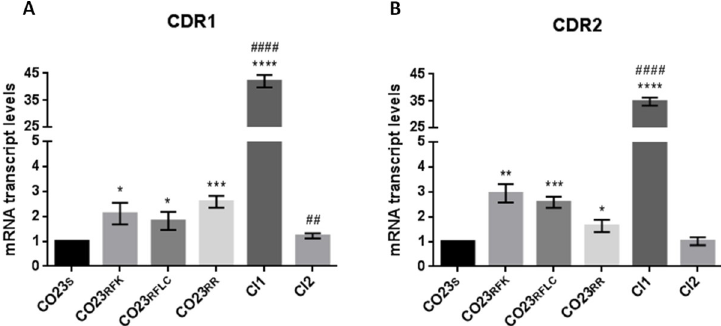
Fig 2. Expression levels of C . albicans CDR1 and CDR2 genes determined by quantitative Real-Time PCR. The expression level of the CDR1 (A) and CDR2 (B) genes in the wild-type (CO23), resistant (CO23RFK, CO23RFLC and CO23RR) strains and Clinical Isolates (CI1 and CI2) are represented as n-fold increase or decrease relative to the level of the control strain (CO23). Data are shown as mean ± SEM from three independent experiments performed in triplicate. � p < 0.05, �� p < 0.01, ��� p < 0.001, ���� p < 0.0001 vs CO23 S and # p < 0.05, ## p < 0.01, ### p < 0.001, #### p < 0.0001 vs CO23 RR